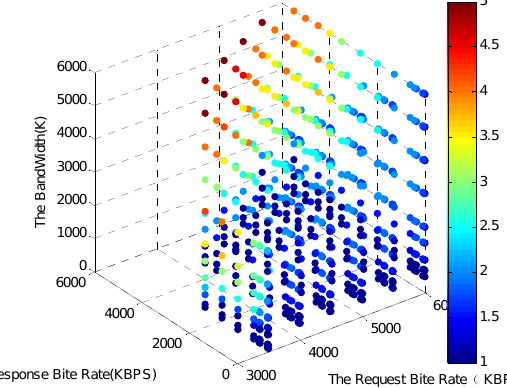
Figure.3 The mapping of the QoE